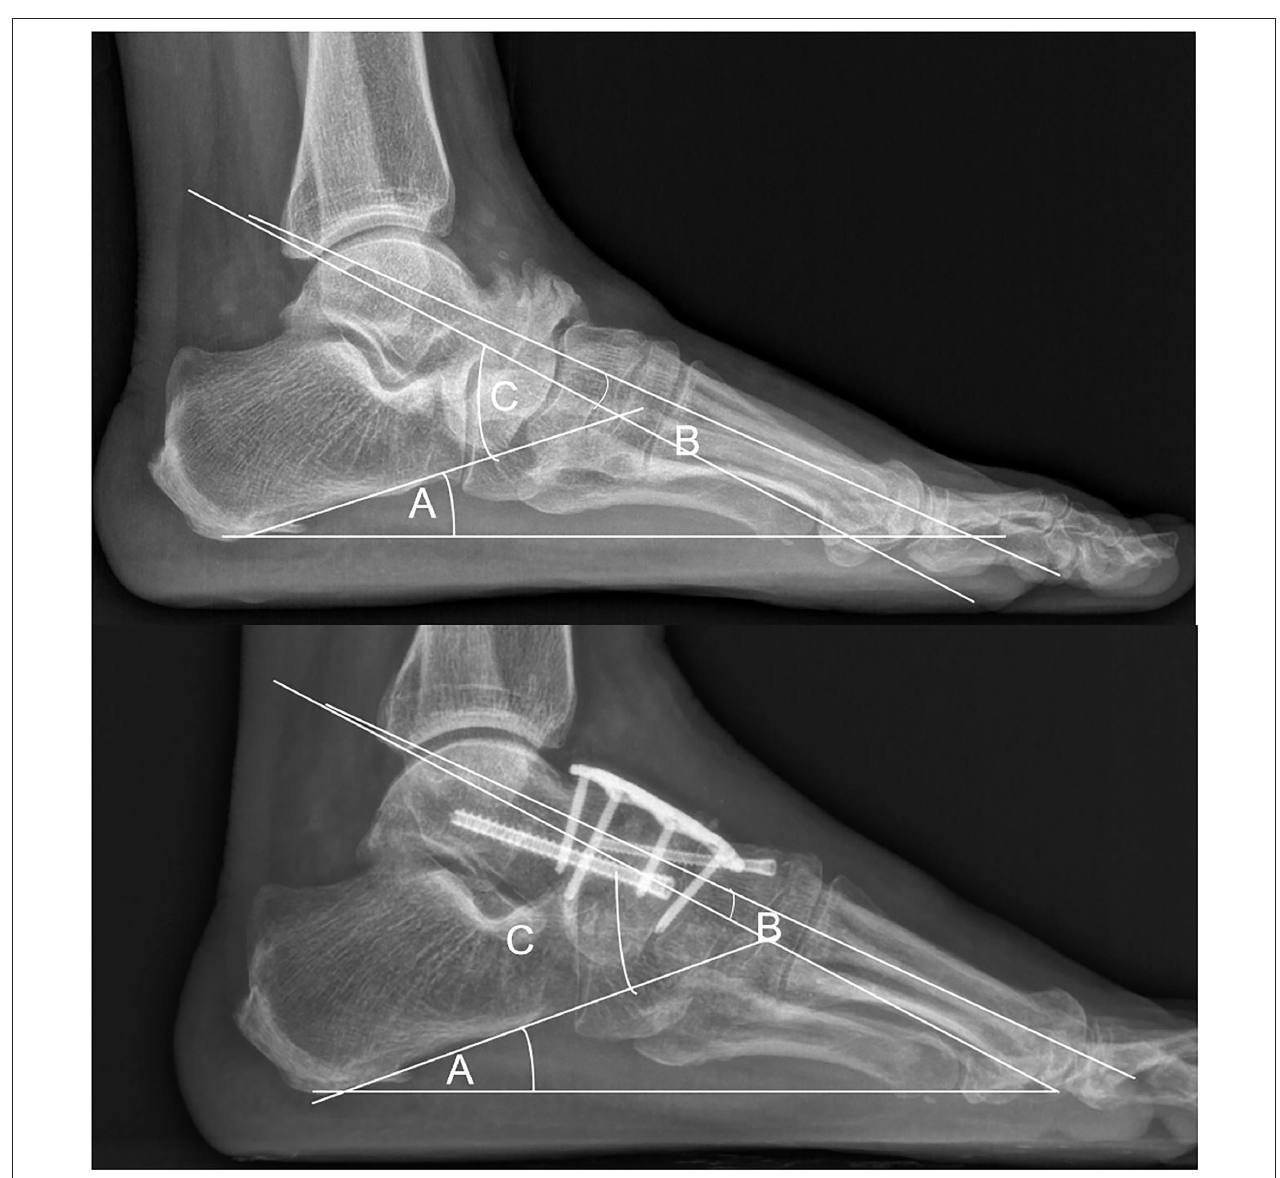
FIGURE 1 | Weight-bearing lateral plain radiograph. (A) The calcaneal pitch angle (CPA). (B) The Temeno-Méary angle in this case was a dorsiflexion angle, given a negative value (TM lat, plantar flexion = positive value, dorsiflexion = negative value). (C) The lateral talocalcaneal angle (TAC lat).